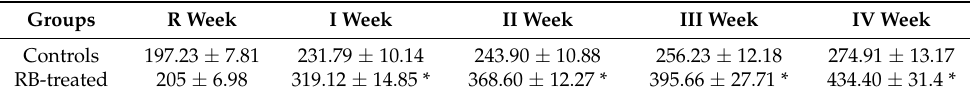
Table 1. Total 24 h fluid consumption expressed in mL in control and RB-treated rats. Groups R